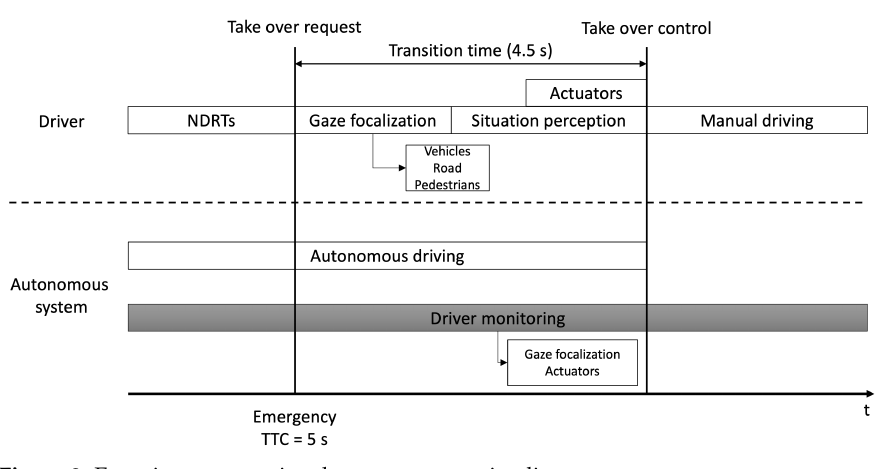
Figure 2. Experiment scenario take-over process